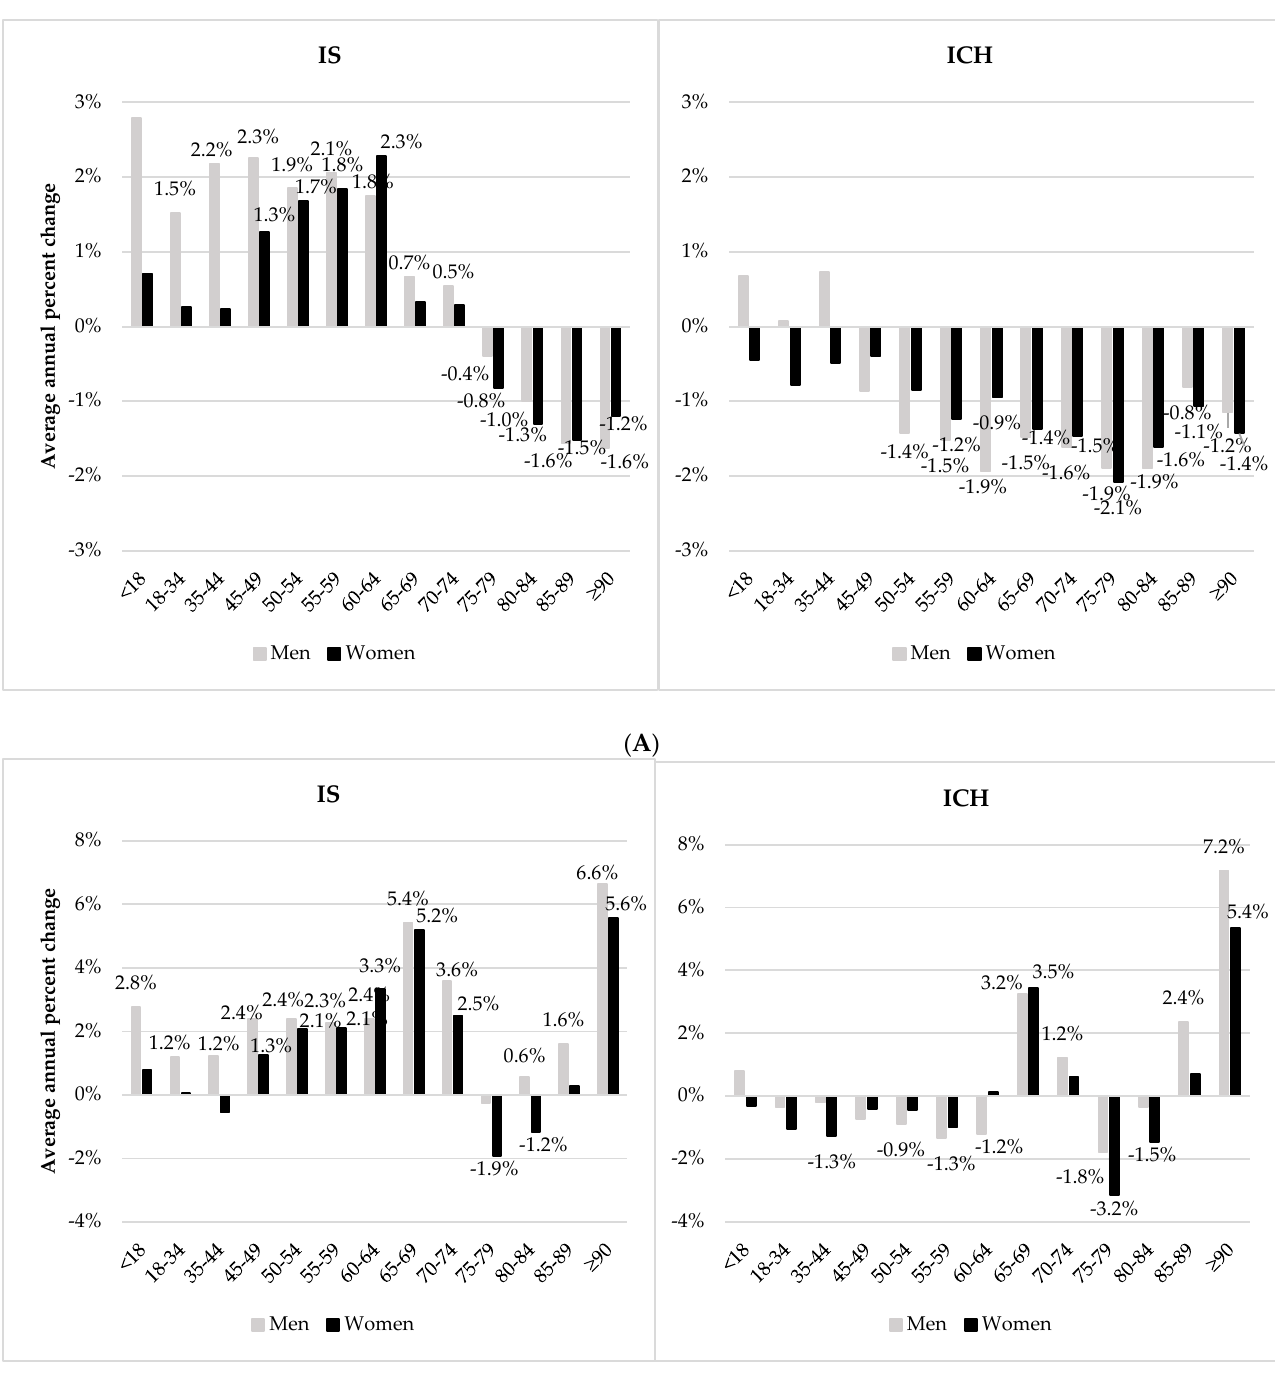
Figure 2. Average annual time trends † in rates and numbers of patients hospitalized for ischemic stroke (IS) and intracerebral hemorrhage (ICH) between 2008 and 2019 in France according to sex and age group. ( A ) Average annual percentage change in the rates of patients hospitalized for stroke. ( B ) Average annual percentage change in the absolute number of patients hospitalized for stroke. † Only significant average annual percentage changes are reported in the figure.